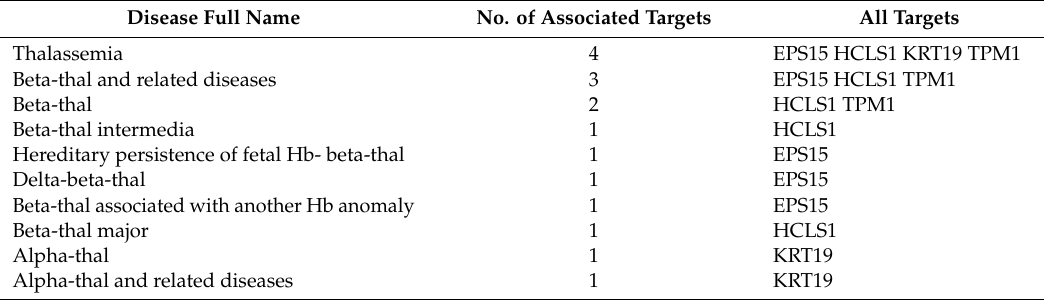
Table 3. List of biomarkers that has an association with thalassemia diseases. A disease association of the 23 antigens showing elevated autoantibody responses was established based on a literature and data mining approach using the Open Targets Platform (https: // www.targetvalidation.org / ) [20].